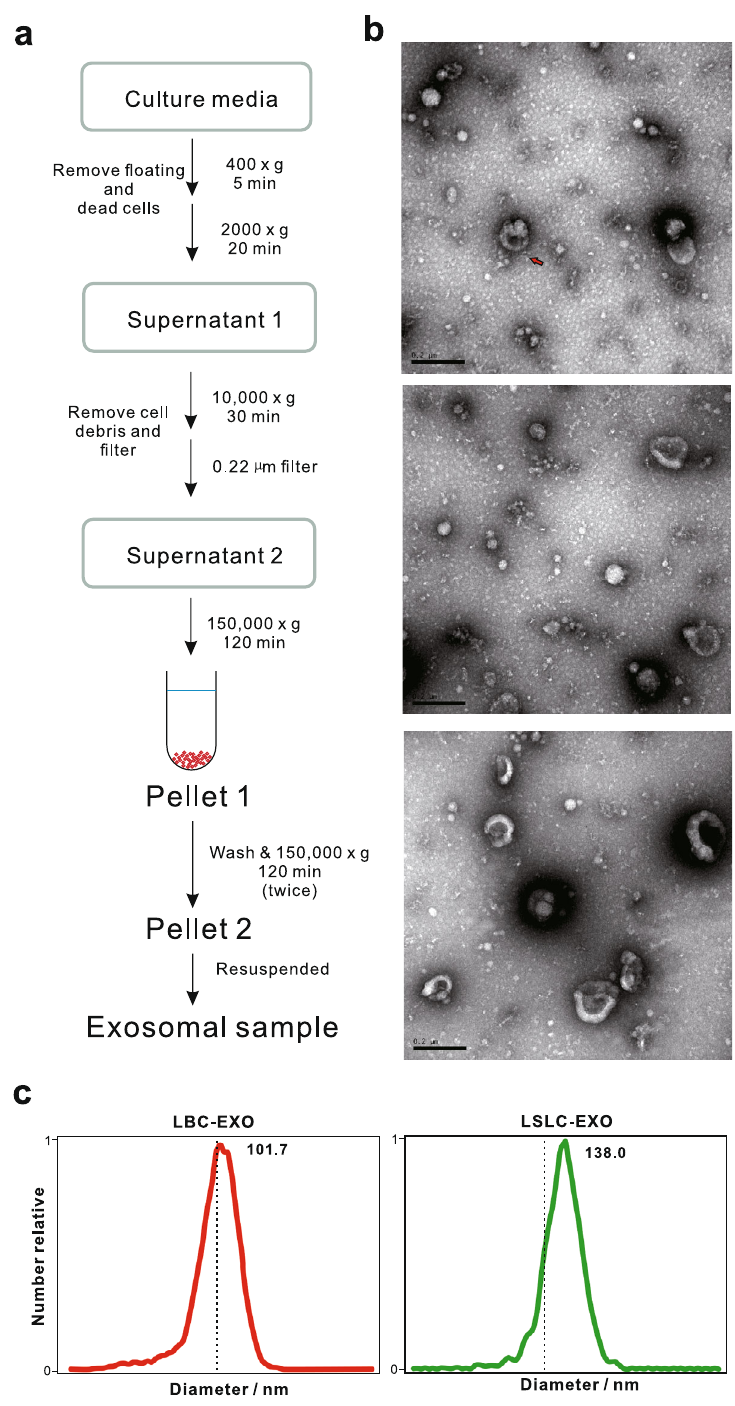
Fig. 2 Isolation and biophysical properties of exosomes. a Schema for isolation of exosomes using multi-step ultracentrifugation. b Transmission electron microscopy (TEM) imaging of exosomes isolated from three replicates of LSLC. Scale bar, 200 nm. c Size distribution pro fi les of exosomes by nanoparticle tracking analysis